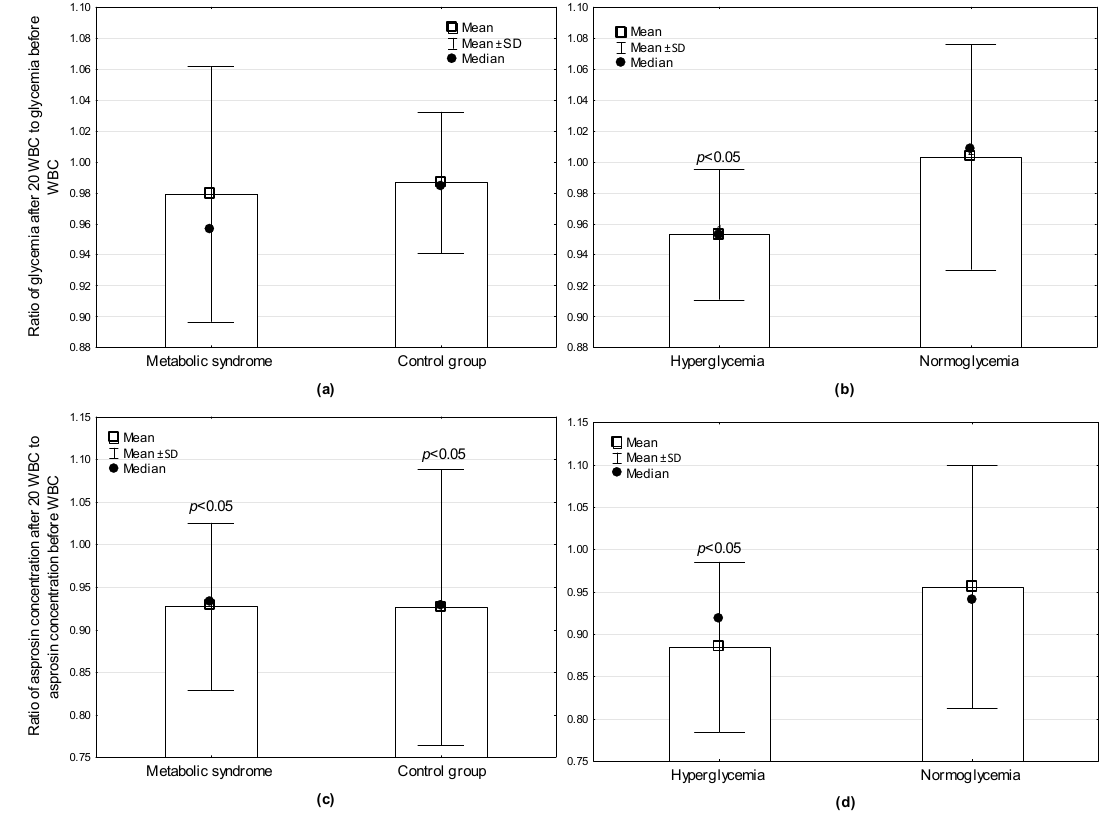
Figure 1. Comparison of changes in plasma glucose and asprosin concentration after 20 whole body cryotherapy treatments in the studied groups: ( a ) change in glucose concentration in the group with metabolic syndrome compared to the control group; ( b ) change in glucose in the hyperglycemic group compared to the normoglycemic group; ( c ) change in asprosin concentration in the group with metabolic syndrome compared to the control group; ( d ) change in asprosin concentration in the hyperglycemic group compared to the normoglycemia group; p < 0.05: statistically significant changes.